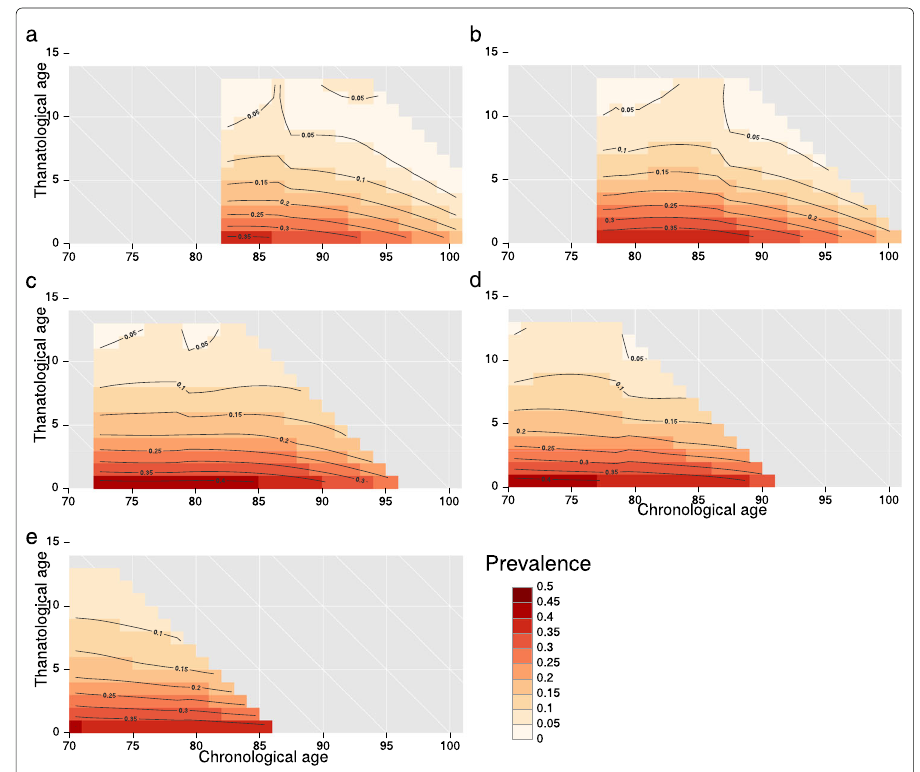
Fig. 7 Prevalence of males self-reporting poor health by chronological and thanatological age, by quinquennial birth cohorts, 1905–1925 (Sources: Health and Retirement Study 2013; RAND 2013)